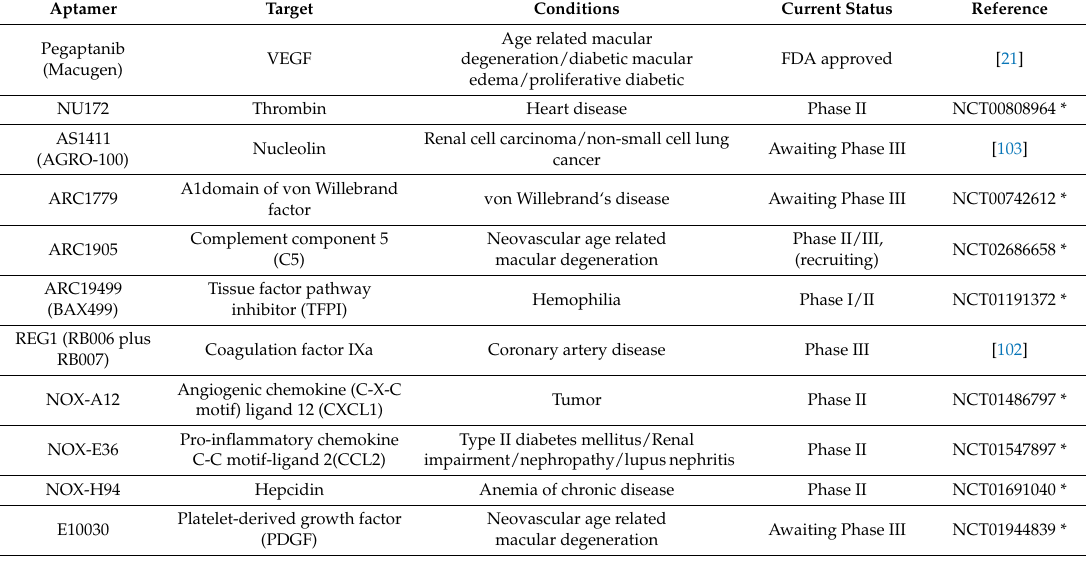
Table 3. Current status of 11 aptamers undergoing clinical